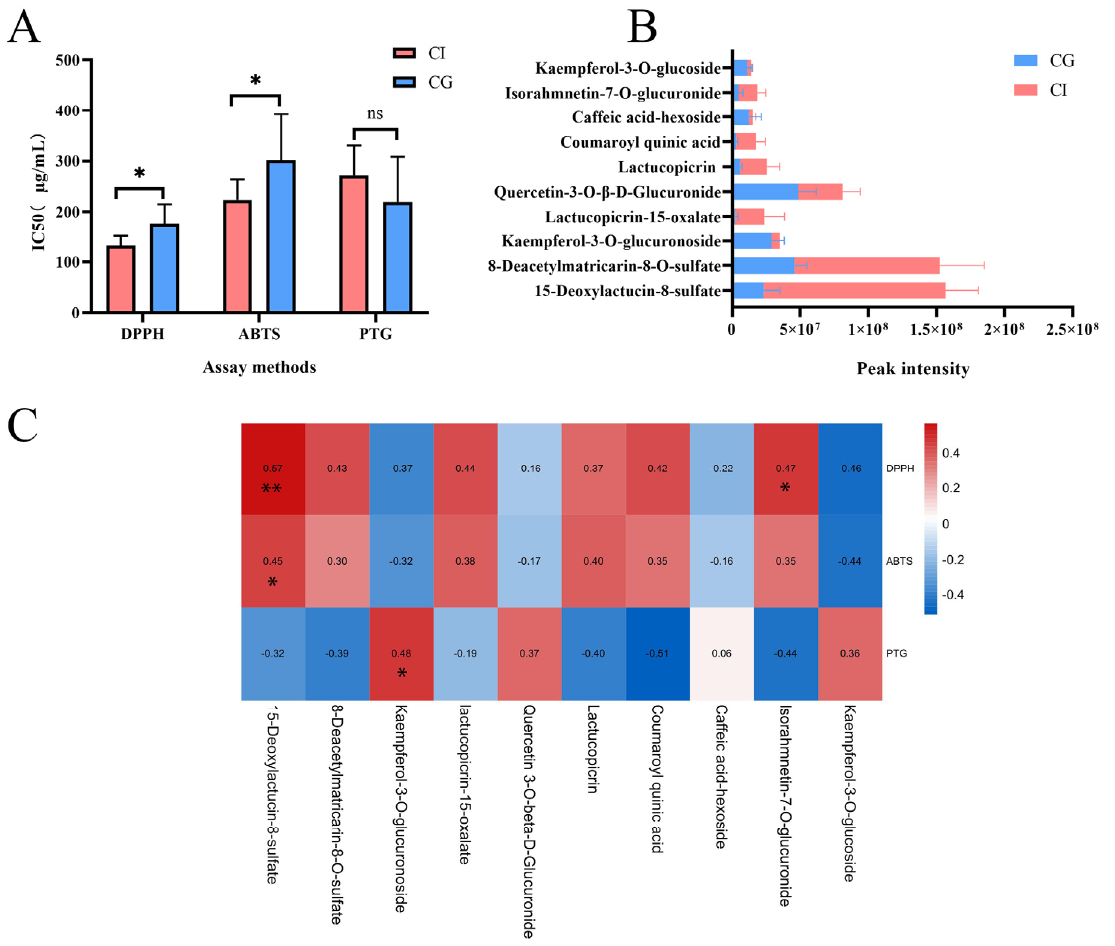
Figure 3. Correlation analysis between activities in vitro and abundance of compounds in CG and CI. ( A ) Comparison of antioxidant activities and hypoglycemic activities between CG and CI evaluated by IC 50 . ns p > 0.05, * p < 0.05 compared with CI. ( B ) The peak intensity of TOP10 components. ( C ) Spearman‘s correlation coefficients to each bioactive compound detected by HPLC. * p < 0.05, ** p < 0.01 compared with peak intensity.